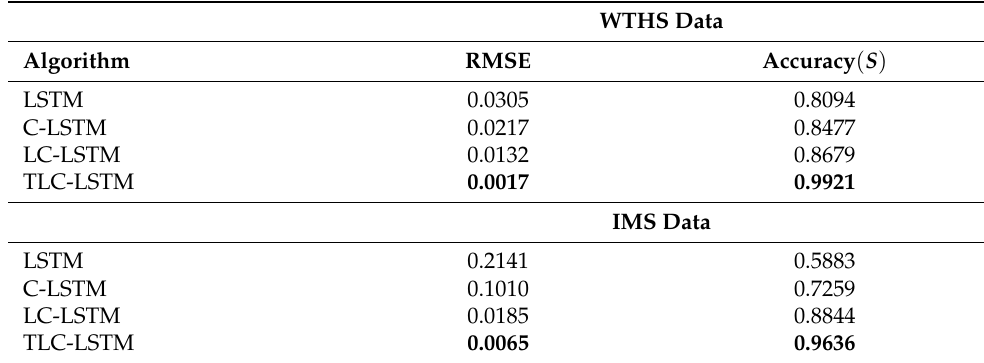
Table 1. Numerical evaluation of the studied algorithms.